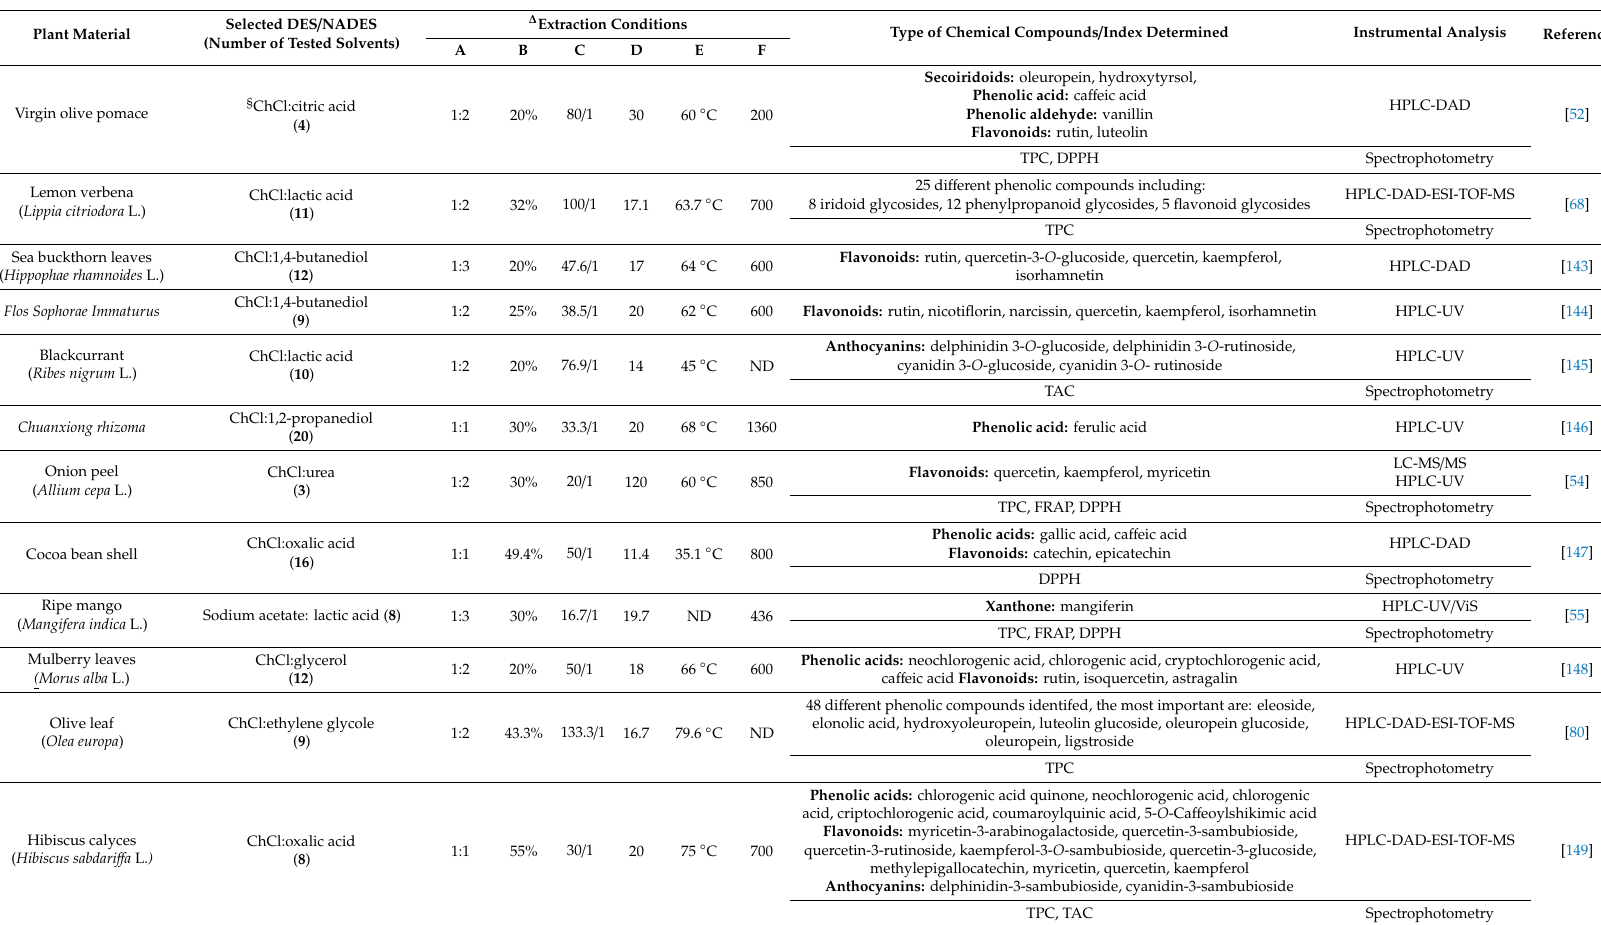
∆ Extraction conditions: A- molar ratio between HBD and HBA in the selected DES / NADES; B-water content in the selected DES / NADES (%); C-solid to liquid ratio (mg · mL − 1 ); D-extraction time (min); E-extraction temperature ( ◦ C); F-microwave power (W). § ChCl- choline chloride. ND- not